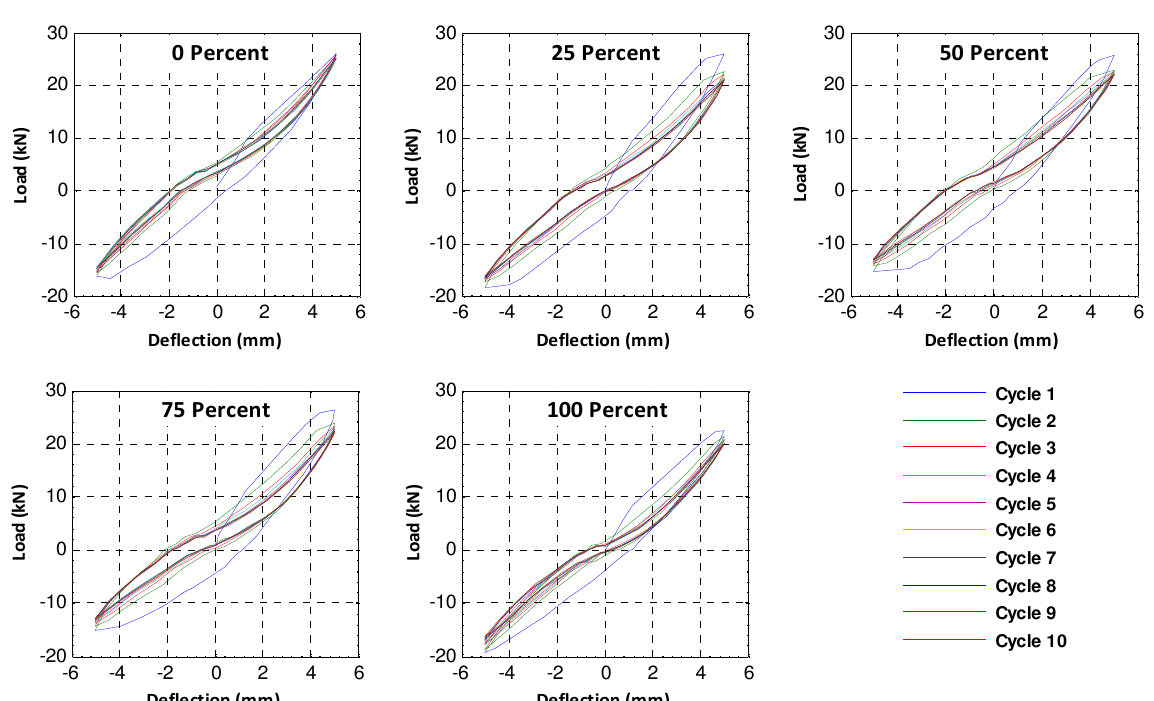
Fig.8: Hysteresis loops (loading cycles of 5 mm amplitude)